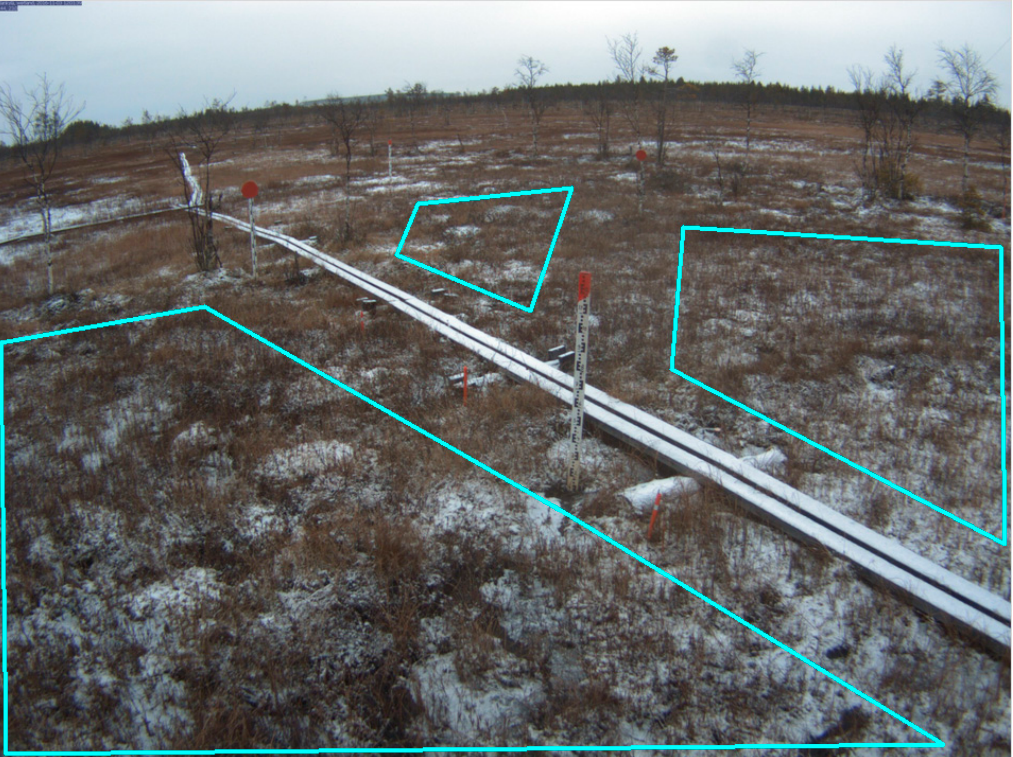
Figure 3. Sodankylä wetland camera region of interest (ROI).